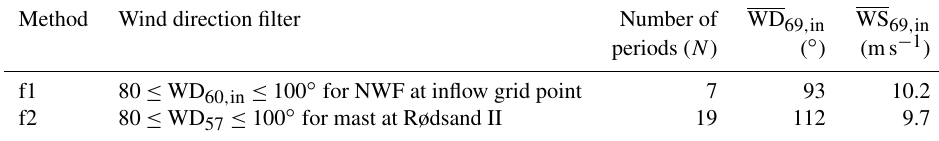
Table 6. Details on filter methods 1 and 2 and corresponding available number of 10min periods, average inflow wind direction (WD) and average inflow wind speed (WS). The subscript “in” refers to the WRF inflow grid point, which is depicted along with the other locations in Fig. 2. Method